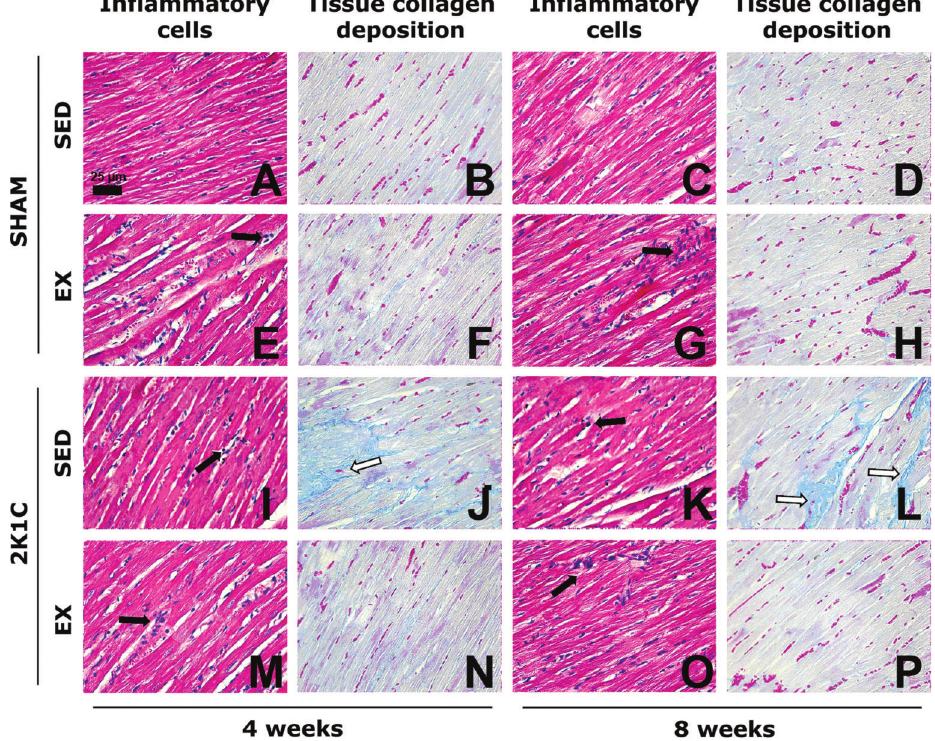
Figure 4. Photomicrographs of the myocardium of normotensive (SHAM) and hypertensive (2K1C) rats, either sedentary (SED) or subjected to physical exercise training (Ex, swimming) for 4 and 8 weeks. The number of in fl ammatory cells is consistent with the framework of normality in SHAM SED rats ( A and C ). The number of in fl ammatory cells (black arrows) is increased in SHAM Ex ( E and G ), 2K1C SED ( I and K ), and 2K1C Ex rats ( M and O ). The area with collagen deposition is compatible with normality in SHAM SED rats ( B and D ). Note the large area of collagen deposition (white arrows) in 2K1C rats ( J and L ) and small area of collagen deposition, similar to the normal pattern of SHAM SED rats, in 2K1C Ex rats ( N and P ). A , E , I , M , C , G , K , and O are stained with hematoxylin and eosin. B , F , J , N , D , H , L , and P are stained with Masson trichrome. All photomicrographs are magni fi ed to 440 (cid:1) (bar=25 m